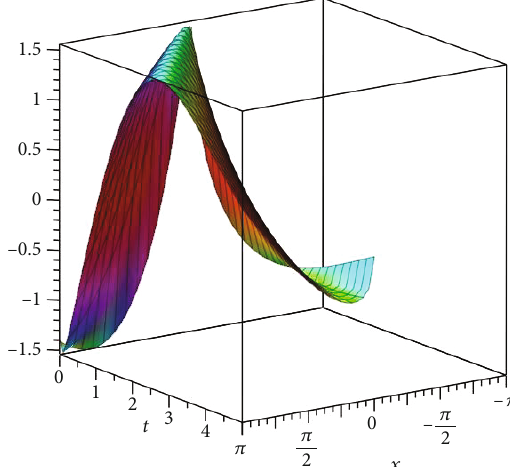
Figure 1: Dynamic behaviors of solution u